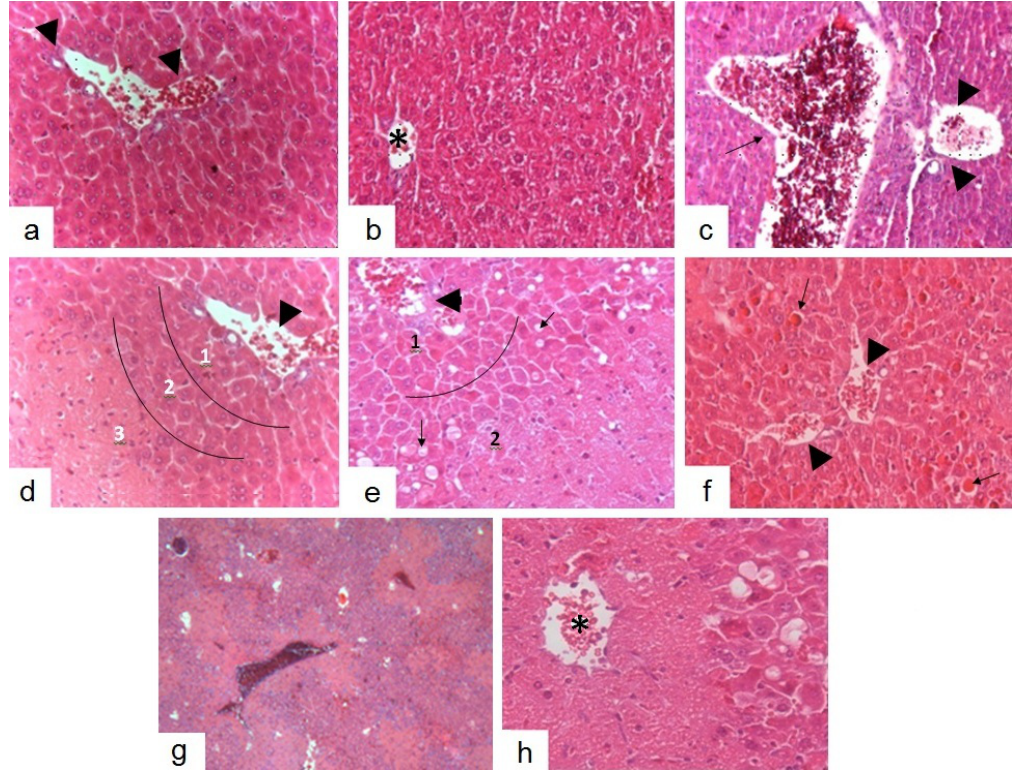
-induced hepatotoxicity in 4